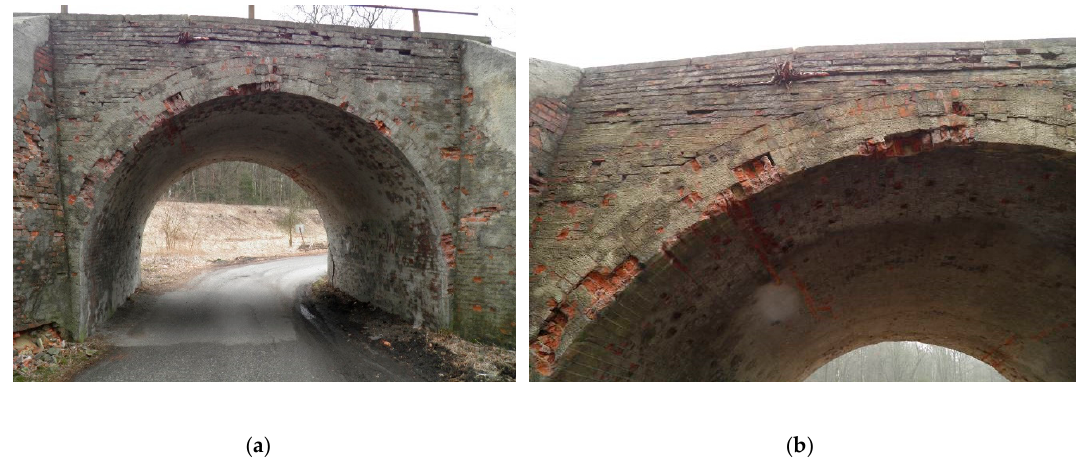
Figure 1. Side view of masonry arch viaduct before restoration: ( a ) Overview, ( b ) visible damage (deflection from the vertical) of the parapet (upper part of the headwall), which was caused by the